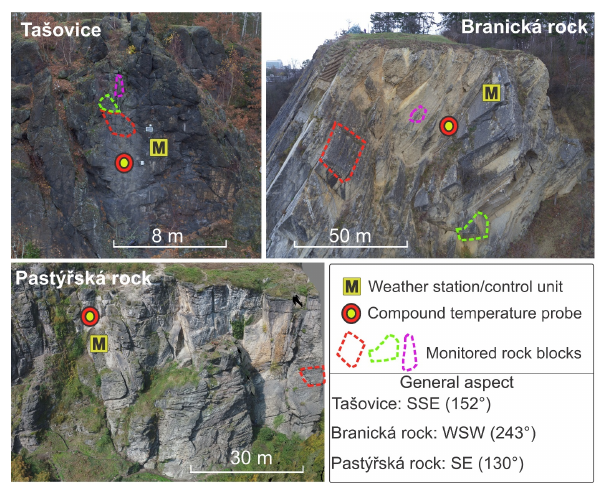
Figure 3. Three instrumented rock slope sites. On each photo, the monitored rock blocks are indicated with dashed lines of a different colour. The placement of the compound borehole temperature probe and weather station is also